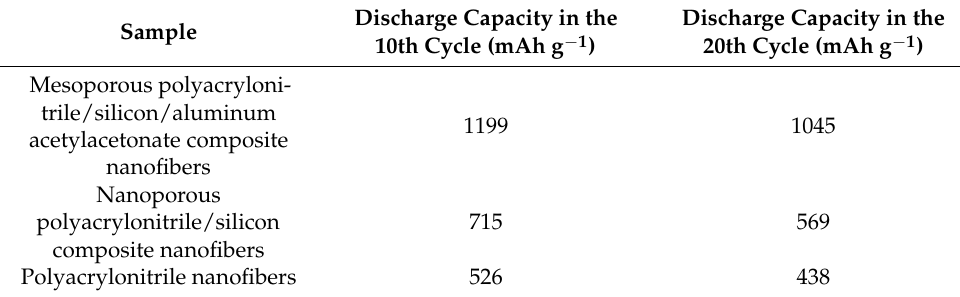
Table 5. Discharge capacity of various porous